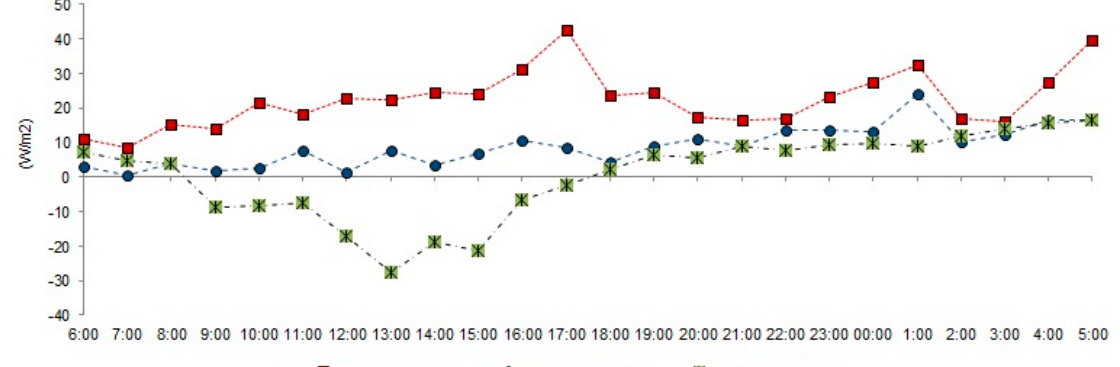
Figure 9. Comparison between heat flux of experiment I, experiment II, and experiment III.